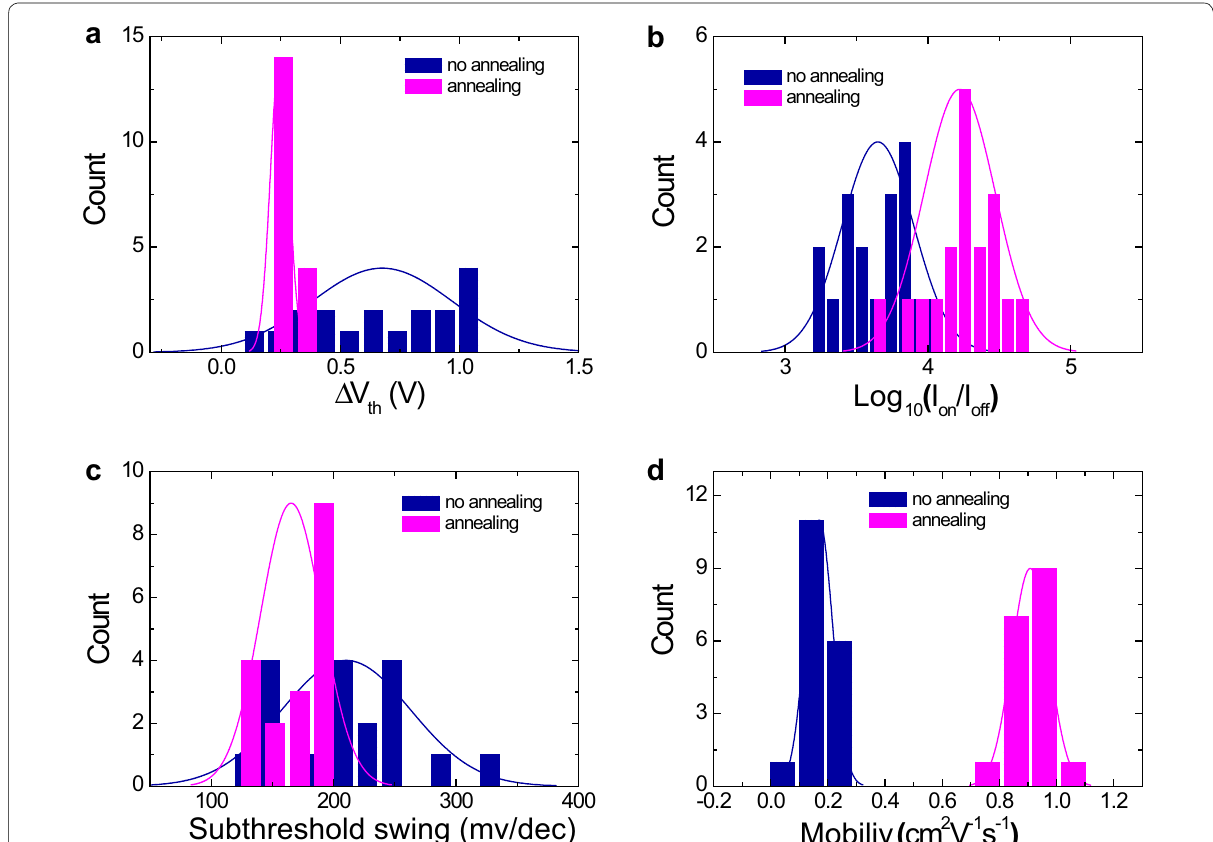
Fig. 2 Histogram of a delta threshold voltage (∆V th : difference between two threshold voltage values obtained from double sweep curves), b on/ off ratio, c subthreshold swing, and d mobility calculated at V G sweeping rage of devices and annealed IGZO transistor